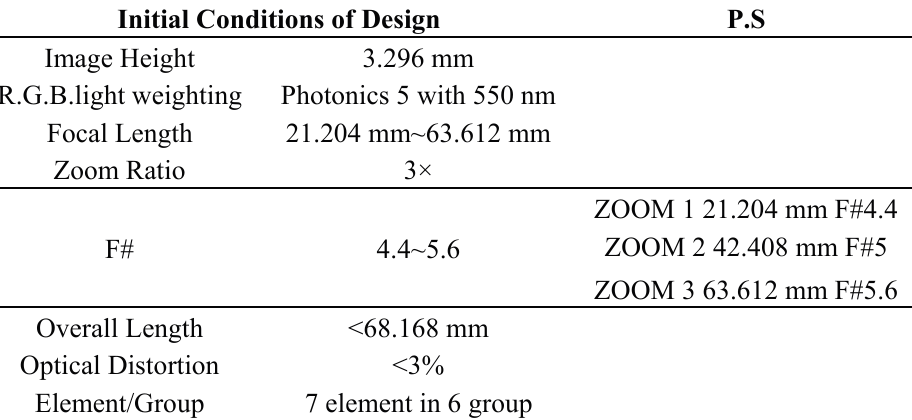
Table 3. The specification of the back zoom lens for overall zoom lens with 9× zoom ratio.